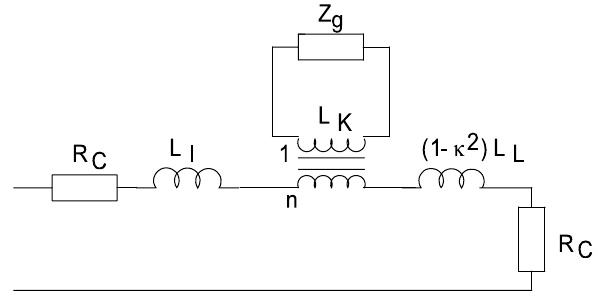
FIG. 1. Lumped kicker magnet circuit